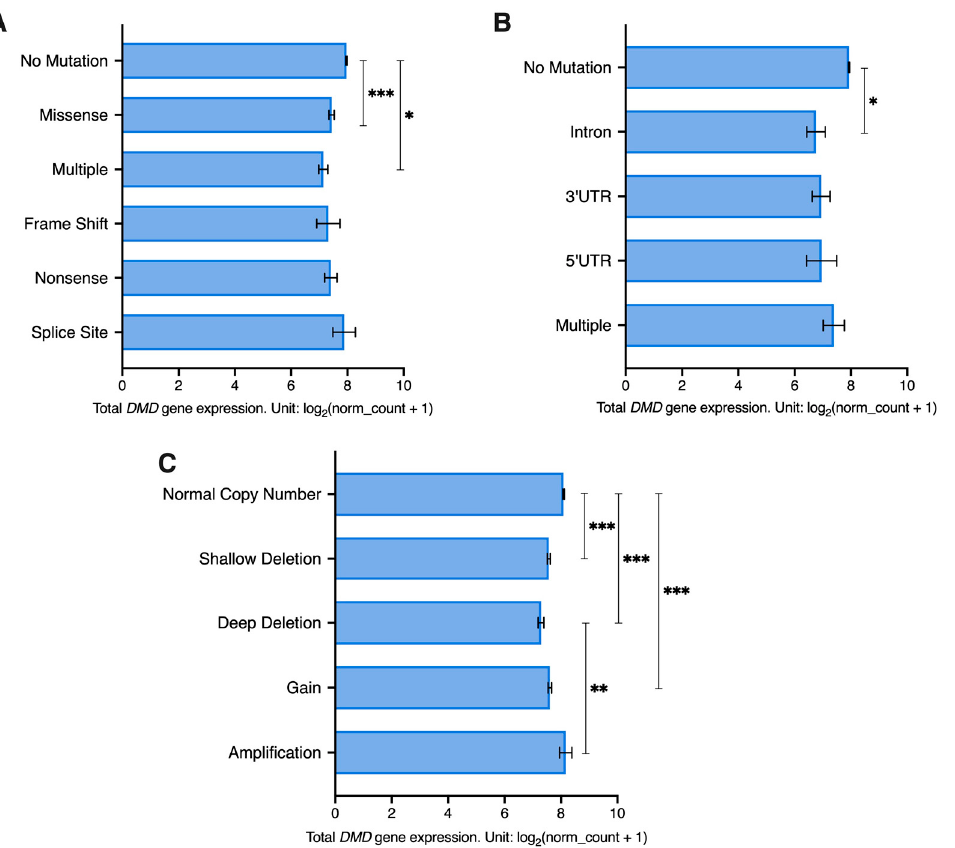
Figure 4. Total DMD gene expression in tumor samples from 23 TCGA studies with/without ( A ) CR, ( B ) NCR mutations, and ( C ) SCNAs in the DMD gene. The number of samples in each group is indicated in brackets. A deep deletion indicates a deep loss (possibly a homozygous deletion). A shallow deletion indicates a shallow loss (possibly a heterozygous deletion). A gain indicates a low-level gain (a few additional copies, often broad). An amplification indicates a high-level amplification (more copies, often local). Expression data is represented as EM mean ± SEM. The p -Values were adjusted using the Bonferroni correction. Asterisks indicate statistical significance (* p < 0.05, ** p < 0.01, *** p < 0.001).